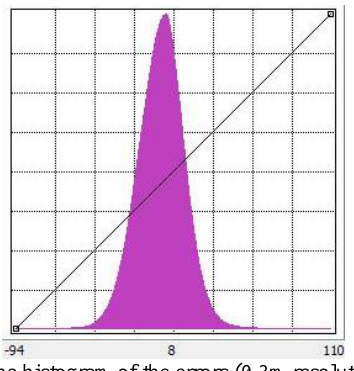
Figure 14. The histogram of the errors (0.3m